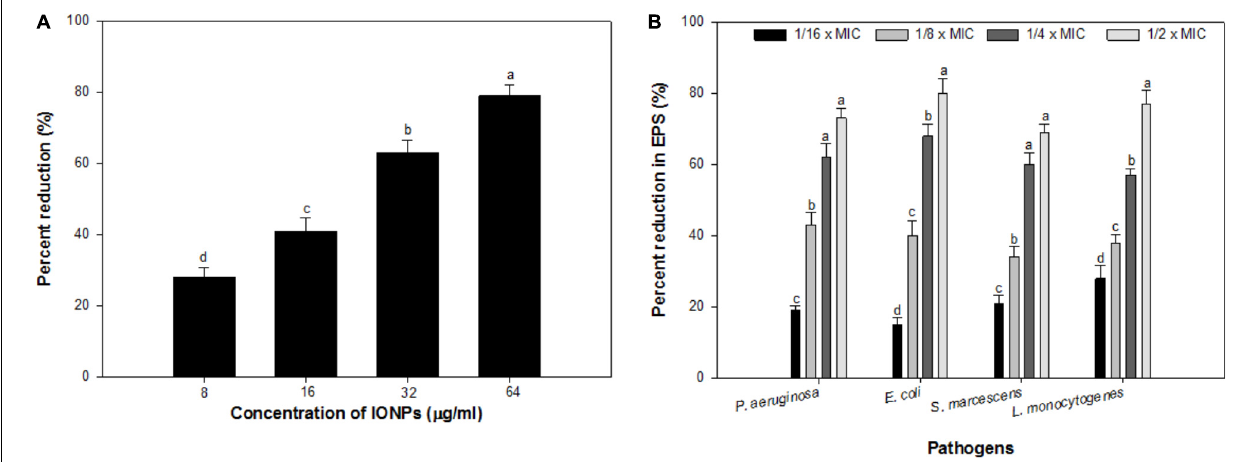
FIGURE 3 | (A) Effect of sub-MICs of IONPs on alginate production in P. aeruginosa PAO1. (B) Effect of sub-MICs of IONPs on EPS production in tested bacteria. Means denoted by the different letter within parameter are significantly different at p > 0.05, using DMRT.